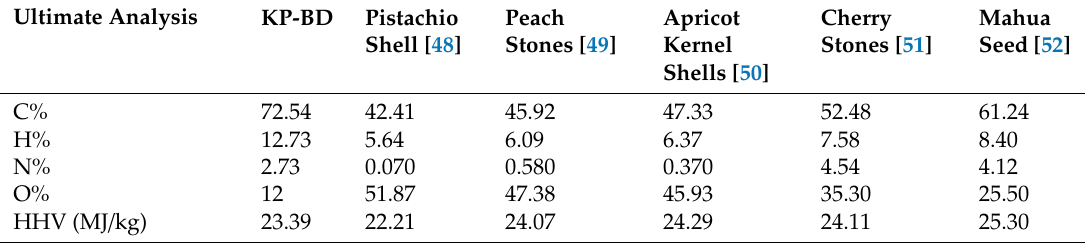
Table 4. Elemental analyzer study of KPBD and their comparison with other plant biodiesel.